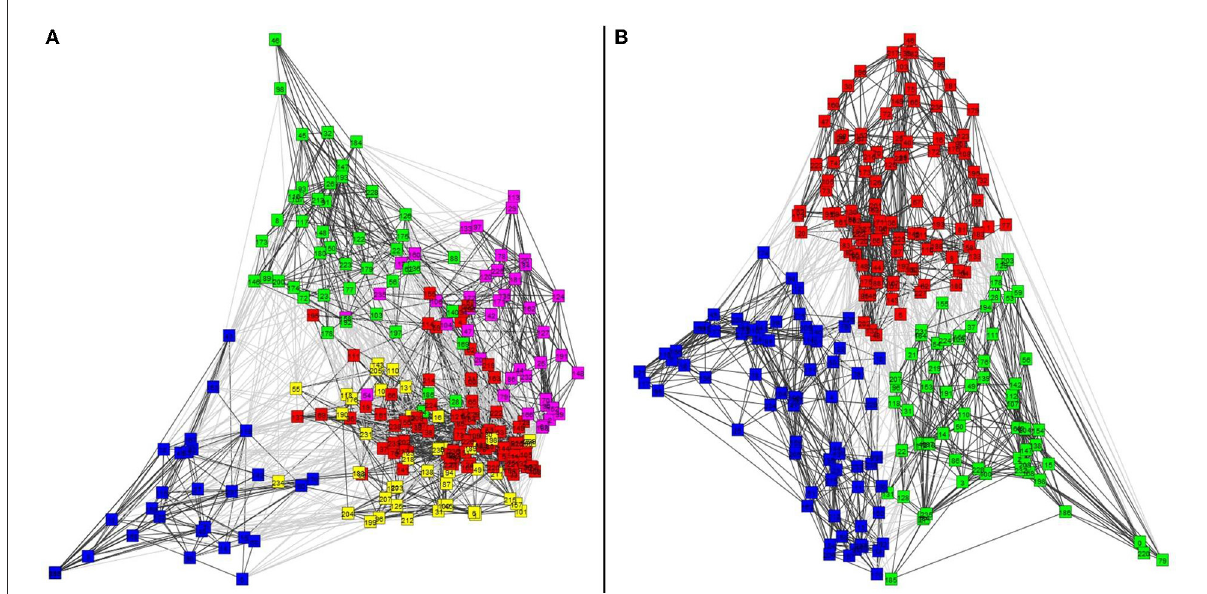
FIGURE7 The clusters of virtual sensors (VS) single trial signals obtained. (A) Shows with different colors, five clusters for the P14-VS detected using the Shi and Malik [28] algorithm and obtained modularity = 0.36 and conductance = 0.44. (B) Shows three clusters for the M20-VS, detected using the Shi and Malik [28] algorithm and obtained modularity = 0.45 and conductance =